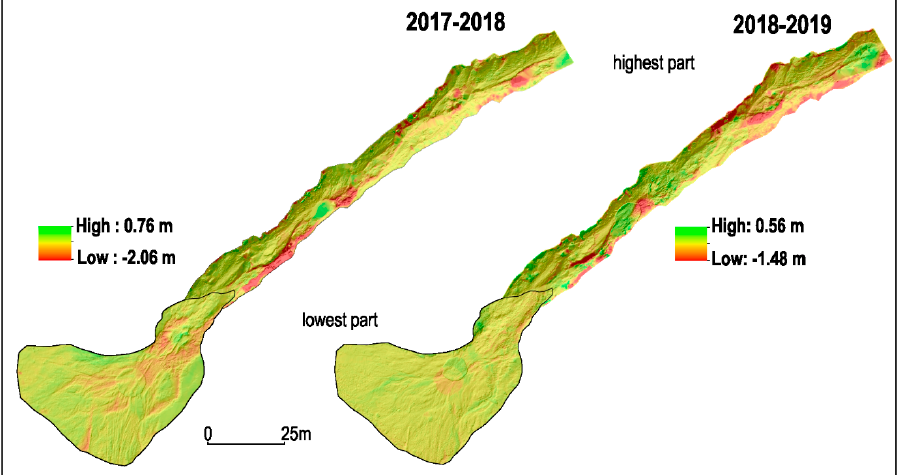
Figure 6. DEM of differences for the sections of forest road and accumulation fan in the period 2017– Figure 6. DEM of di ff erences for the sections of forest road and accumulation fan in the